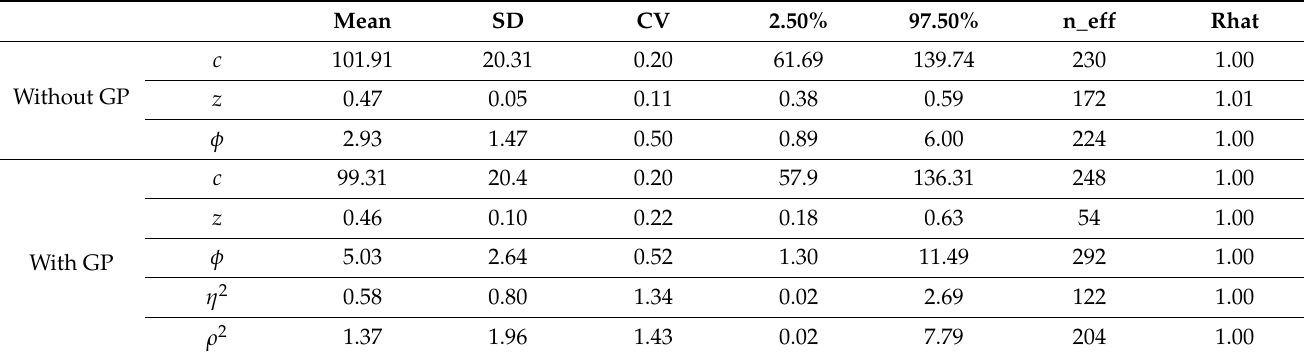
Table 2. Stan output for the ISAR model with and without the Gaussian process (GP) for the Canary Islands. “SD” stands for standard deviation, “CV” for coefficient of variation, “2.50%” and “97.50%” correspond to the width of the credible interval, “n_eff” is the effective sample size and “Rhat” stands for ˆ R (see main